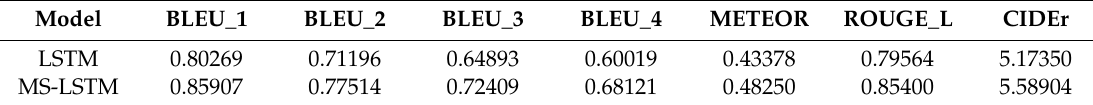
Table 3. Metrics of the LSTM and MS-LSTM for the validation set.